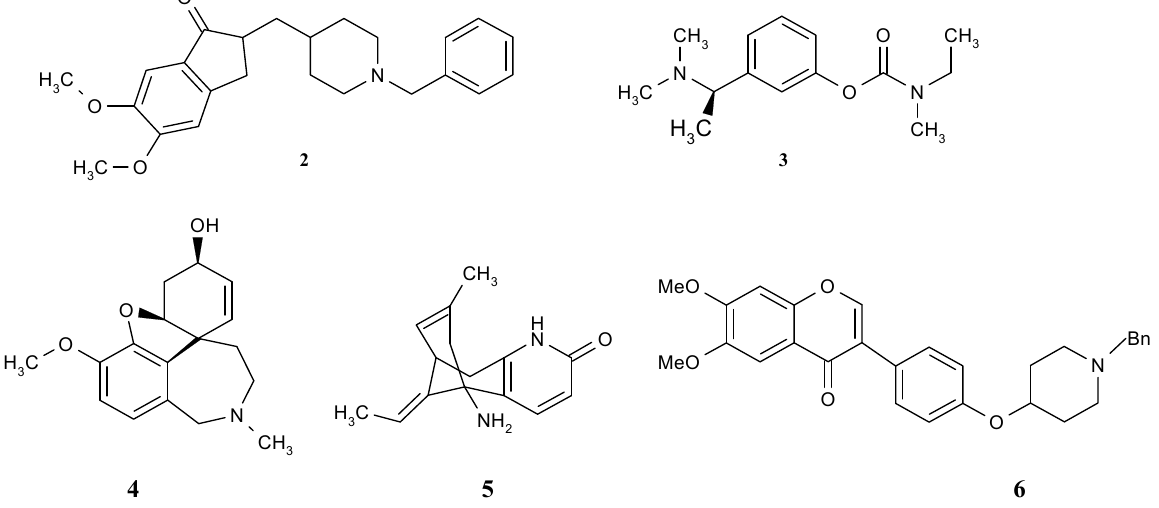
Figure 2. Selected AChE inhibitors-donepezil ( 2 ); rivastigmin ( 3 ); galantamine ( 4 ); Huperzine A ( 5 ); and flavonoid derivative ( 6